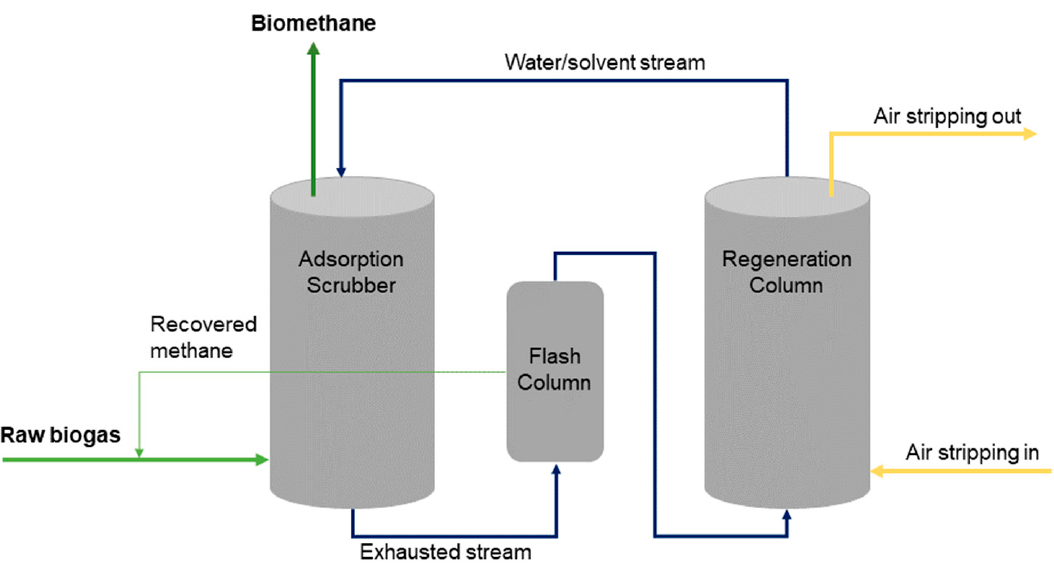
Figure 5. Scheme of a water scrubbing plant for biogas upgrading. Adapted with permission from [23]; published by Elsevier, 2021.